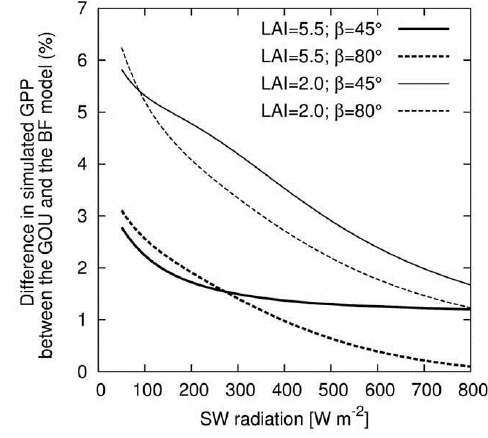
Fig. 4. Difference in simulated GPP (%) between the GOU and BF model using a LAI of 2.0 (thin lines) or 5.5 (thick lines) using a solar elevation of 45 ◦ (solid lines) or 80 ◦ (dotted lines).